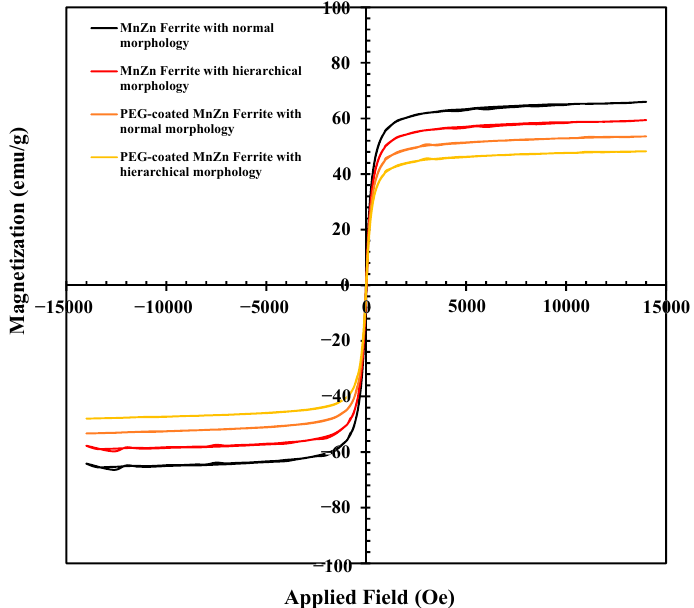
Figure 8. Magnetic hysteresis loops of the PEG-coated and uncoated MnZn ferrite nanoparticles with di ff erent morphologies. In the MRI technique, the contrast improvement directly corresponds to the Ms value of the contrast agent. Superparamagnetic nanoparticles such as MnZn ferrite as contrast agents could produce negative contrast images by reducing the signal intensity to produce dark images. In vitro T 2 -weighted MR images (Figure 9a) were taken from PBS media containing di ff erent concentrations of both the nanopowders with and without PEG coat- ing and compared with PBS as the control. Figure 9a demonstrates that adding PEG- coated and uncoated MnZn ferrite nanoparticles to PBS as the control considerably im- proved the contrast quality of MR images. As can be predicted, this improvement got bet- ter as the nanoparticle concentration increased in both instances. However, the PEG- coated nanoparticle dispersions as well as bare nanoparticles with hierarchical structure exhibit slightly less improvement in the contrast of MR images than uncoated nanoparti- cles with normal structure. This result agrees well with the magnetic characteristics deter- mined using VSM (Figure 8). The presence of the non-magnetic PEG coating on the surface of nanoparticles is often related to this, as was previously indicated. The contrasting im- pact of the produced MnZn ferrite nanoparticles is decreased as a result of this layer’s protection against protons [15]. Bare MnZn ferrite nanoparticles with normal morphology also showed the highest relaxivity of 380.5 mM − 1 s − 1 . In addition, the interesting result is that all the samples synthesized in this work exhibit higher relaxivity (Figure 9b) than reported values for some commercially approved MRI contrast agents of superparamag- netic iron oxide such as Feridex, Resovist, and Combidex at 1.5 T [31]. However, it must be noted that not only some parameters of ferrite nanoparticles such as the crystallinity, composition, size, morphology, and magnetic properties are responsible for T 2 contrast but also the characteristics of nonmagnetic polymers as coatings must be considered. Cho